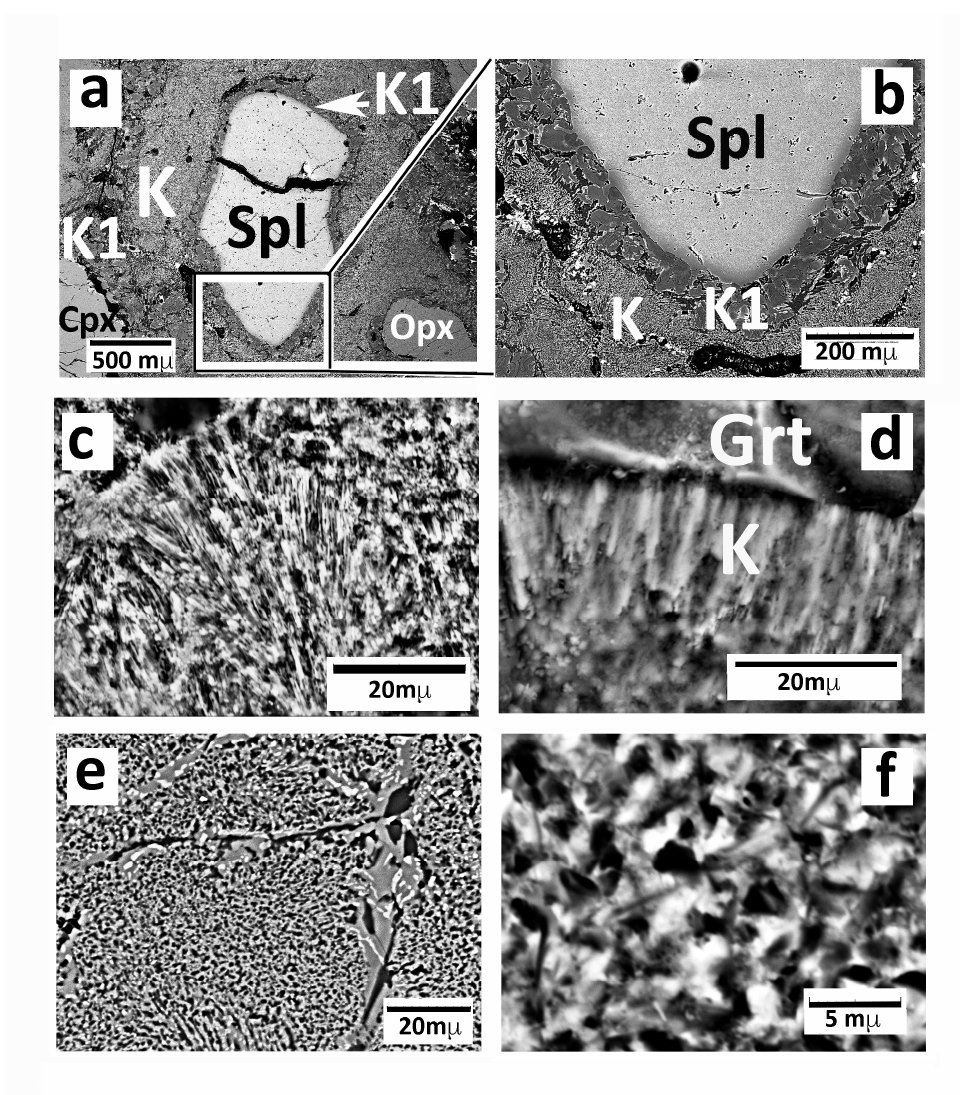
Figure 3. Scanning electron microscopy (SEM) images in backscattered electron mode (BSE) showing details of thin-sections and fragments of the sample highlighting typical kelyphite textures. ( a ) Typical Al-spinel grain (Spl), with rounded edges, immersed in the fine kelyphite (K), which fully replaces former garnet. A collar of coarser-grained kelyphite (K1) occurs around the spinel and nearby clinopyroxene (Cpx) and orthopyroxene (opx) grains. The area enclosed in the rectangular inset is displayed in figure ( b ) at higher magnification. ( c ) 3-D view of the fine kelyphite in a small fragment of the sample. Bright mineral is spinel, dark gray is ortophyroxene, most of the black spots are void volumes. ( d ) The same as in ( c ) showing the sharp passage between kelyphite and the fresh garnet (Grt). ( e ) Kelyphite as it appears in thin section. Clear areas consist of spinel, gray areas mostly consist of Ca-poor pyroxene, dark area are either Ca-rich plagioclase, alteration products of plagioclase or empty spaces. ( f ) High magnification of the kelyphite evidencing porosity, as the dark spots mostly consist of void